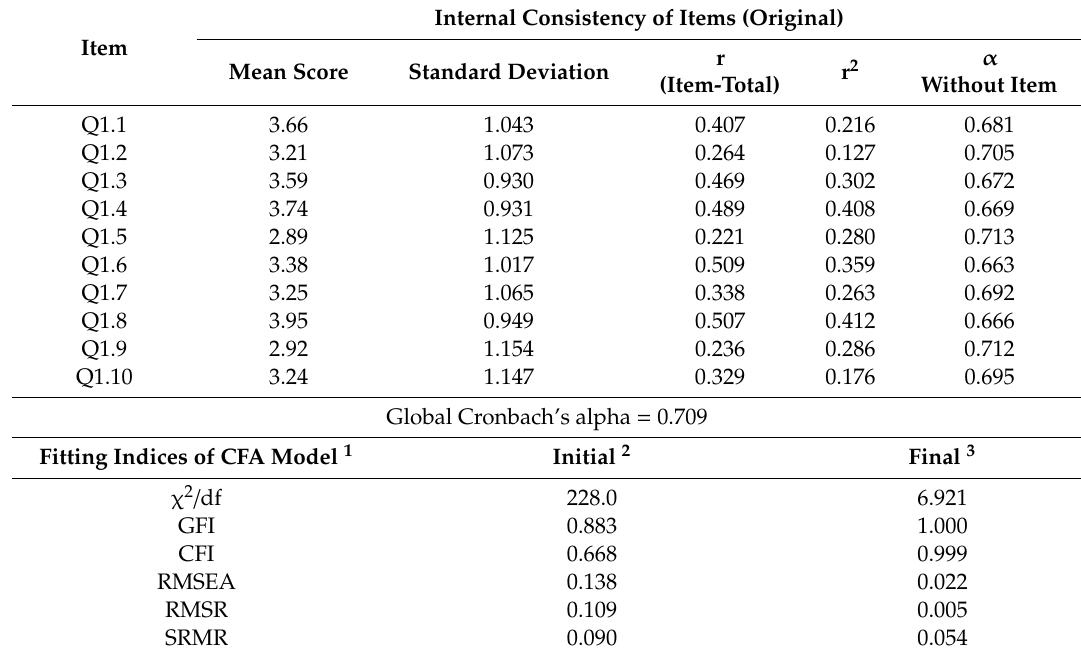
Table 1. Statistics for the unidimensional model of the scale about health